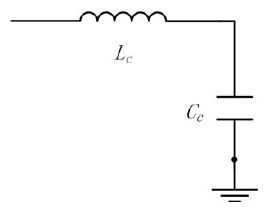
Figure 4. Equivalent circuit of the pump chamber.